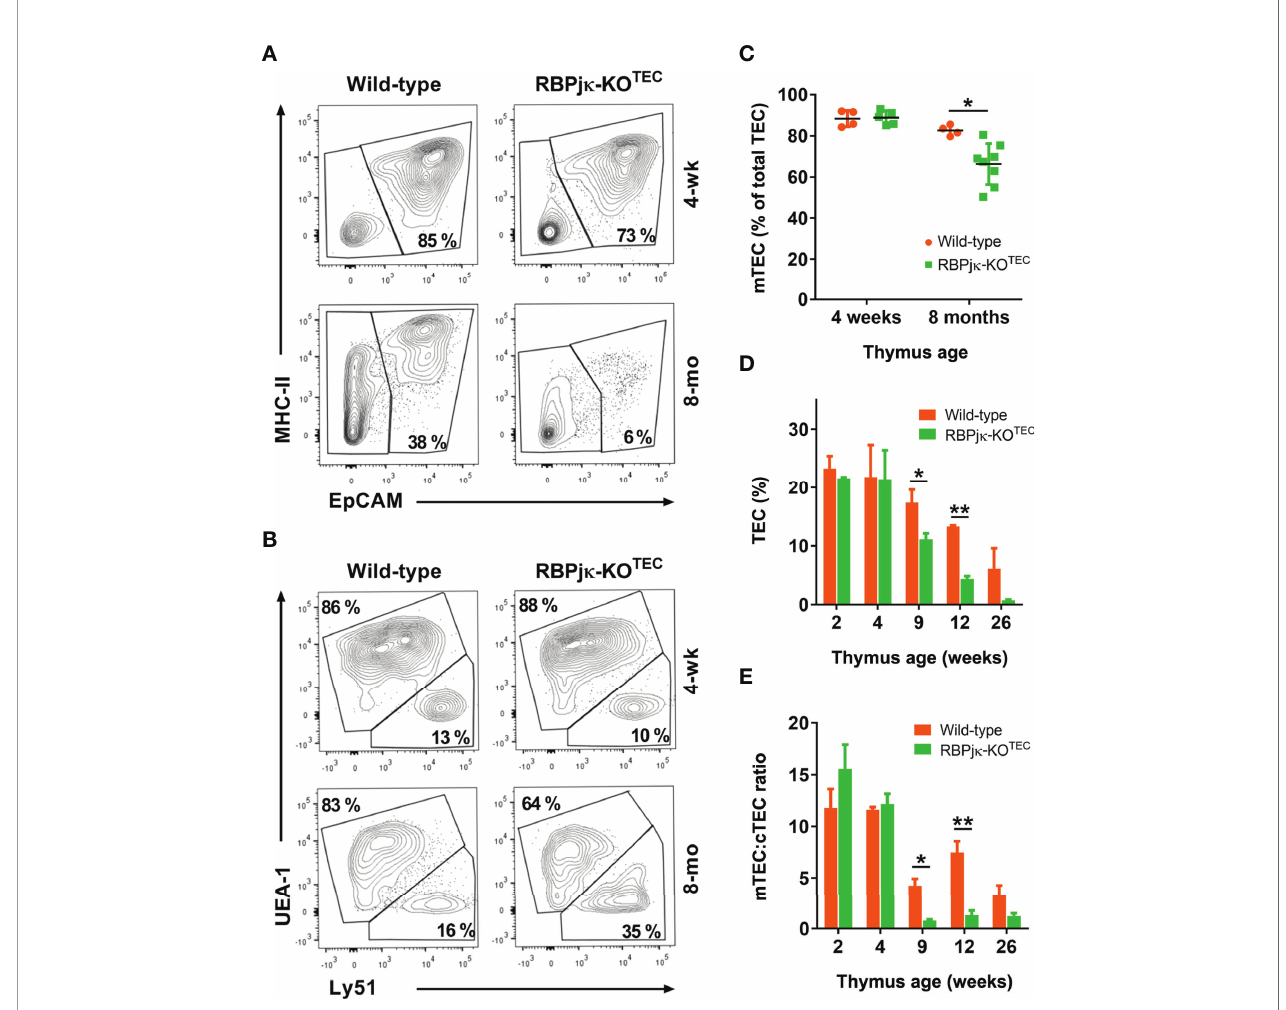
FIGURE 5 | Foxn1 -controlled abrogation of canonical Notch signaling leads to an accelerated age-associated loss of postnatal mTECs. (A) Representative fl ow cytometry MHC-classII and EpCAM expression analysis of CD45- and Ter-119-depleted cell suspensions of collagenase/dispase-treated young (4-weeks) and old (8-months) thymi from RBPj k – KO TEC mutant and Foxn1 +/+ x RBPjk fl / fl littermate WT mice (n ≥ 8). (B) Representative fl ow cytometry analysis of UEA1 and Ly51 expression on gated EpCAM+ TECs in (A) , (n ≥ 4). (C) Relative numbers of UEA1 + mTECs among EpCAM + TECs from RBPj k – KO TEC and Foxn1 +/+ x RBPjk fl / fl WT thymi of the indicated ages, analyzed as in B). Data are shown as mean percentages ± SEM (n ≥ 4 thymus samples per age). (D) Relative numbers of EpCAM + TECs present in cell suspensions obtained as in (A) from thymi of Foxn1 +/+ x RBPjk fl / fl WT and RBPj k – KO TEC mutant mice aged 2- to 26-weeks. Data are shown as mean percentages ± SEM (n ≥ 3 thymus samples per age). (E) Ratio of mTEC:cTEC proportions among total EpCAM + TECs from WT Foxn1 +/+ x RBPjk fl / fl and mutant RBPj k – KO TEC thymi at the indicated postnatal ages. Data show mean values ± SEM (n ≥ 4 thymus samples per age). *p<0.05; **p<0.01. p values were calculated using a two-tailed